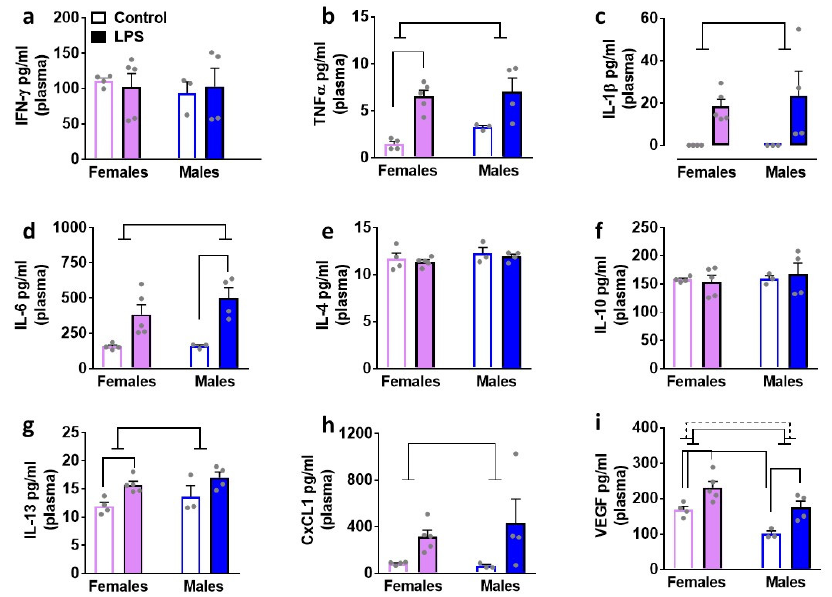
Figure 3. Cytokines, chemokines, and VEGF were measured in the plasma of female and male rats that were exposed to LPS or saline injections. control female, n = 5 LPS female, n = 3 control male, n = 4 LPS male. Pro-inflammatory cytokines are indicated in panels a-d. Anti-inflammatory cytokines are indicated in panels e-g. Chemokine is indicated in panel h and angiogenesis marker is indicated in panel i. Main effect of LPS ( p < 0.05) is indicated by solid line with flat arrowheads and main effect of sex ( p < 0.05) is indicated by dashed line with flat arrowhead. Differences between saline and LPS within each sex and between sexes ( p < 0.05) are indicated by separate solid lines.